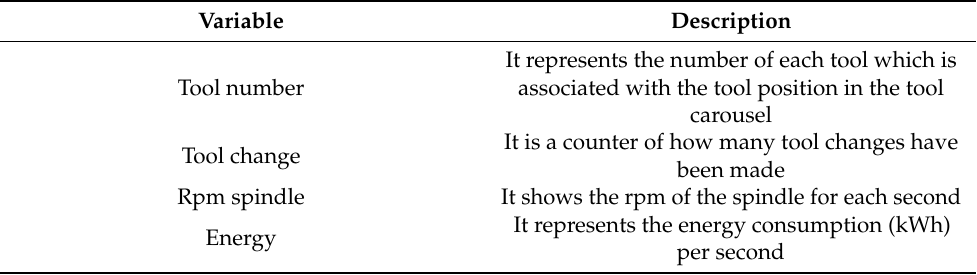
Table 1. Description of the variables.